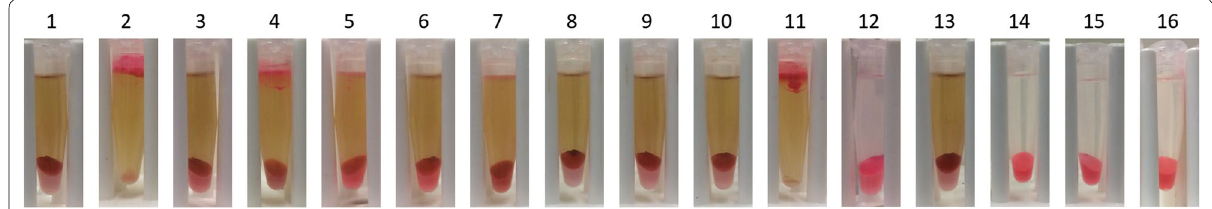
Fig. 3 Pretreatment screening analysis. The pretreatment screening analysis exposed the Schwanniomyces occidentalis fat cells to chemicals, microwave or autoclaving pretreatment for 24 h prior to addition of the tailor-made enzymes (TMEs). The release of oil was visualized after 24 h of TME incubation time by the addition of Nile red. Sample (1) 1 M NaCl, (2) 1 M NaOH, (3) 1 M NH 4 OH, (4) 1 M HCl, (5) 1 M H 3 PO 4 , (6) 1 M CH 3 COOH, (7) microwave procedure (700 W, 10 min), (8) 1% (v/v) Triton X-100, (9) 1% (v/v) Tween-80, (10) 50 mM DTT, (11) autoclave procedure (121 °C/20 min), (12) control sample with demi water as a pretreatment step and demi water as a lysis procedure, (13) control sample with demi water as a pretreatment step and lytic enzymes as a lysis procedure, (14) control sample with 1 M NaOH as pretreatment step and demi water as a lysis procedure, (15) control sample with HCl as a pretreatment step and demi water as a lysis procedure, (16) control sample by autoclave procedure (121 °C/20 min) and demi water as a lysis